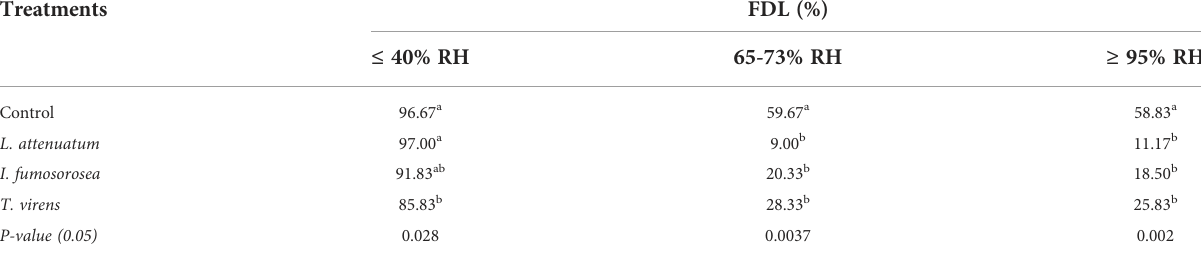
TABLE 1 The fi nal disease level (FDL) of the cucumber leaves treated with microbiological control agents, Lecanicillium attenuatum (LLA), Isaria fumosorosea (IFR), and Trichoderma virens (TVI), and the untreated control (control) on the 20 th day.